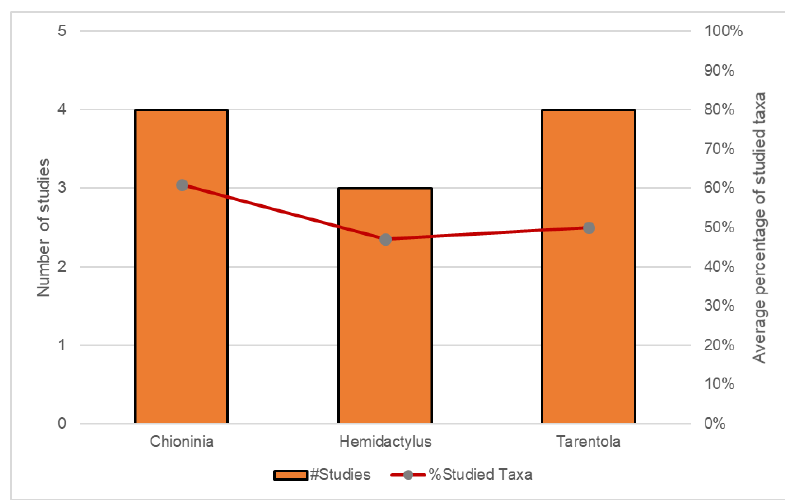
Figure 2. Number of studies (columns) and percentage of studied taxa (red line) within Macaronesian reptile lineages.